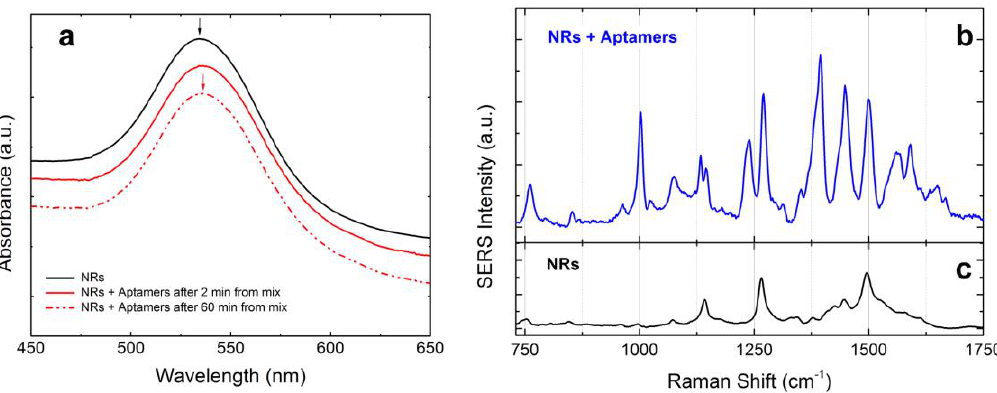
Figure 10. ( a ) Extinction spectra of the CTAB-coated gold NRs (black line) compared to ones functionalized with the aptamers after 2 min of incubation (red solid line) and after 60 min of incubation (red dashed line). The functionalization induces a red-shift of 2 nm that does not change with time. Spectra are offset for clarity. ( b ) SERS signal from the NRs + aptamer complexes optically aggregated at the bottom of the glass microcell (P = 5 mW, T = 1 s). The signal results averaged over 100 consecutive spectra. ( c ) SERS signal (reference) acquired from the CTAB-coated NRs precipitated at the bottom of the glass microcell (P = 1.8 mW, T =1 s) in absence of aptamers.